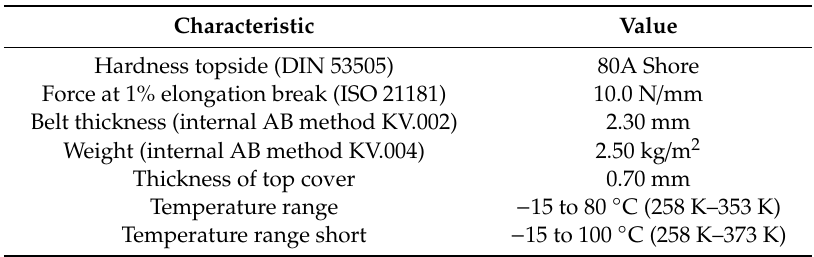
Table 2. Technical belt data (based on [20]).